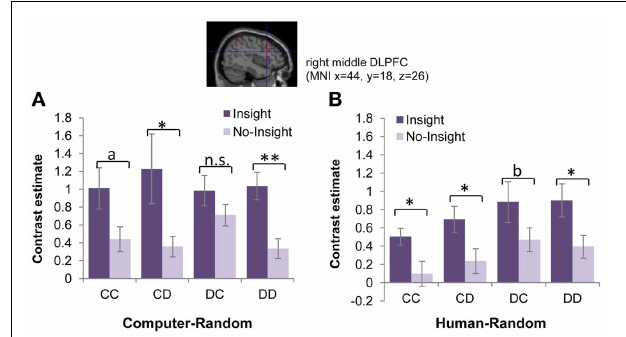
FIGURE 3 | Representation of insight into reciprocity of partner strategy in the right middle DLPFC. Significant activation in the right middle DLPFC [(44, 18, 26), FWE corrected p < 0 . 05] distinguished the insight and no-insight groups when the partner’s identity (computer or human) and payoff outcome were controlled. Bar plots represent mean comparisons of activation in the right middle DLPFC between the insight and no-insight groups for each payoff outcome. Error bars represent standard errors. ∗∗ p < 0 . 01; ∗ p < 0 . 05; a p = 0 . 066; b p = 0 . 067; n.s. = not significant (two-tailed t -test). (A) Computer-random (CR) session. (B) Human-random (HR)